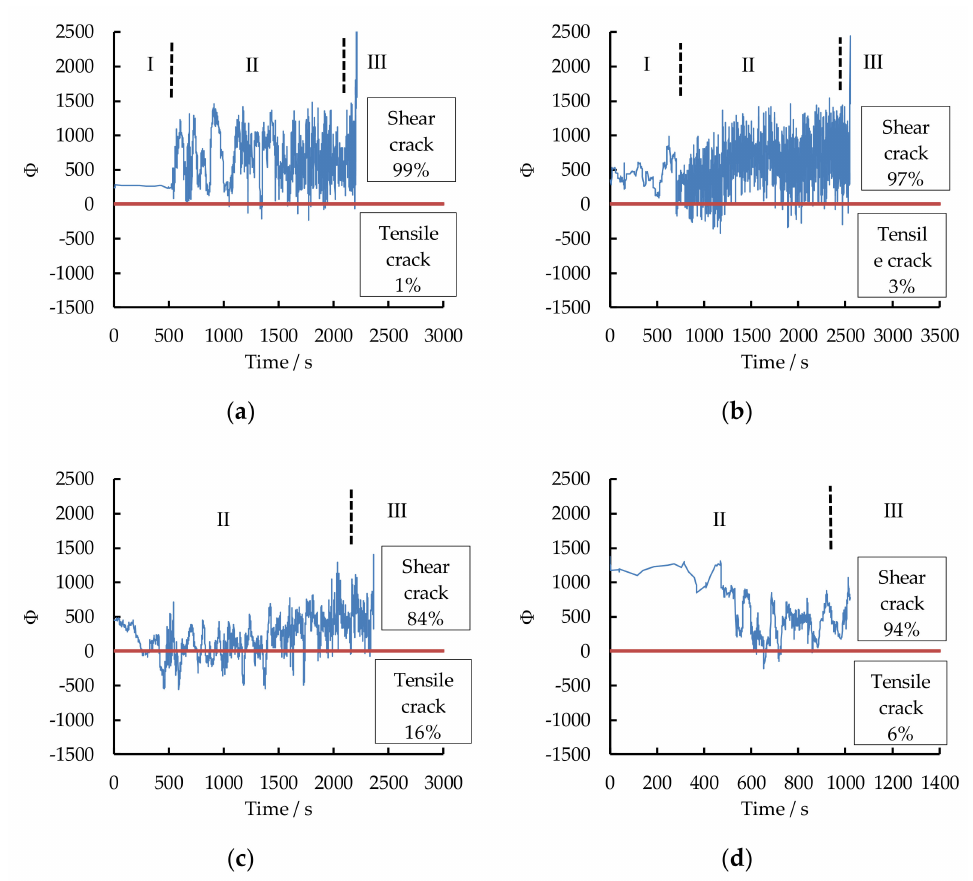
Figure 14. RA-AF association analysis: ( a ) RPC beam; ( b ) BFRPC beam; ( c ) BFRPC-N beam; ( d ) BFRPC-N-ID